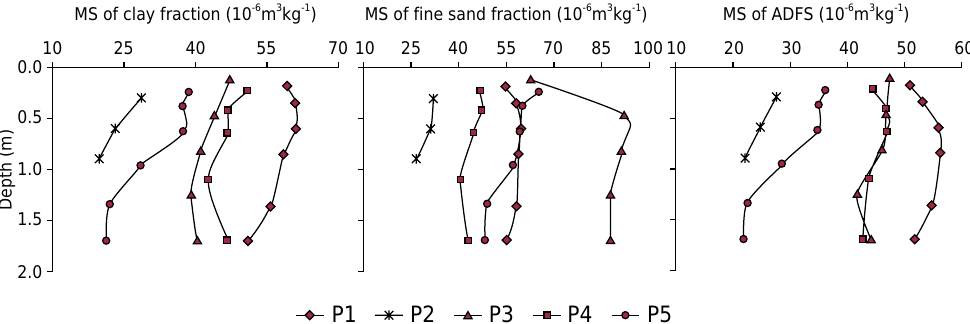
Figure 4. Magnetic susceptibility (MS) of the clay, fine sand and air-dried fine soil (ADFS) measured at low frequency for each layer and profile (P). P1: Haplic Ferralsol (Dystric, Clayic); P2: Haplic Ferralsol (Dystric, Clayic); P3: Rhodic Eutric Nitisol (Ochric); P4: Rhodic Ferralsol (Dystric, Clayic); P5: Rhodic Ferralsol (Eutric,